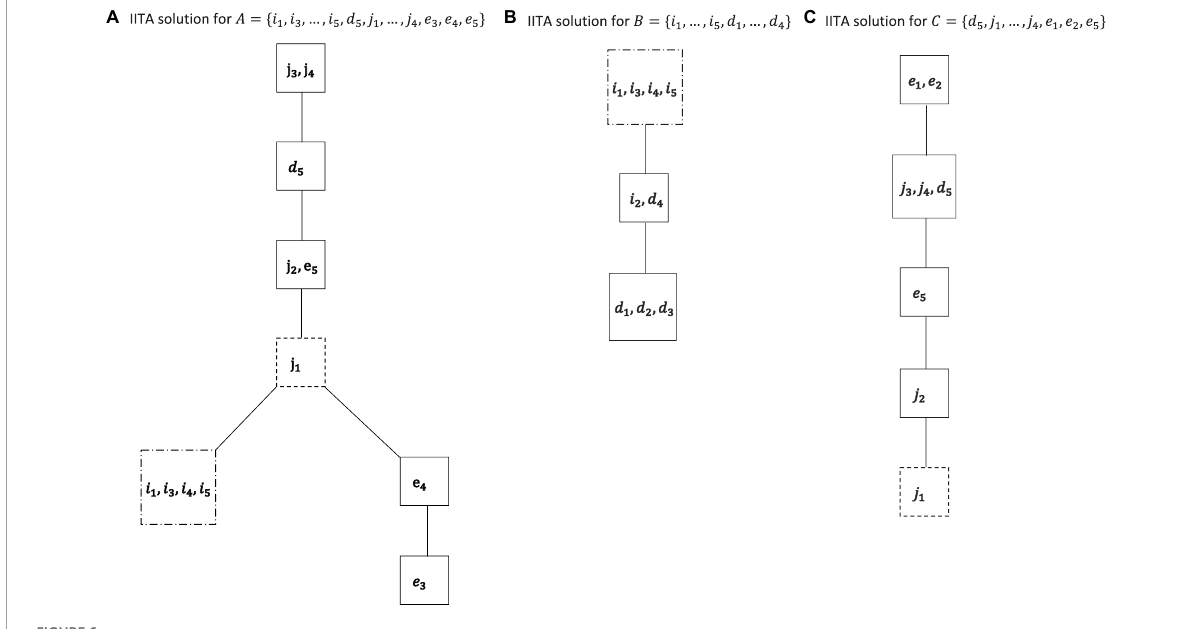
FIGURE6 IITA computations for the motivations A = { i 1 , i 3 ,..., i 5 , d 5 , j 1 ,..., j 4 , e 3 , e 4 , e 5 } (A) , B = { i 1 ,..., i 5 , d 1 ,..., d 4 } (B) , and C = { d 5 , j 1 ,..., j 4 , e 1 , e 2 , e 5 } (C) of the empirical data set. The dashed boxes indicate the respective linkage knots for the three graphs ( Figure 7